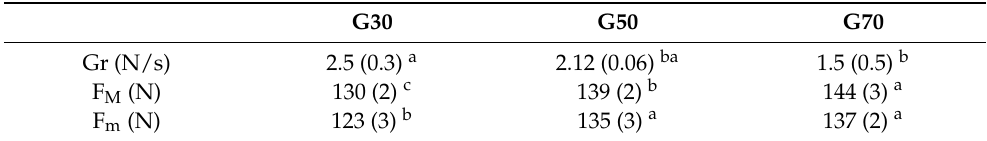
Table 2. Mean values (and standard deviations) of extrusion parameters (Gr, Gradient; FM, maximum force; Fm, mean force) of apricot gel before 3D